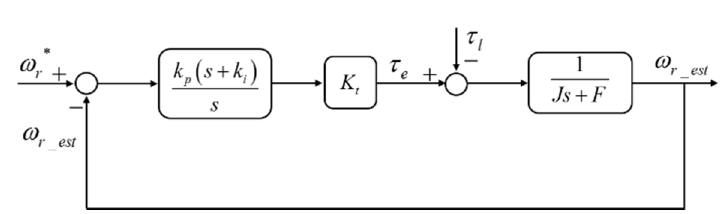
Figure 9. Simplified block diagram of speed controller.